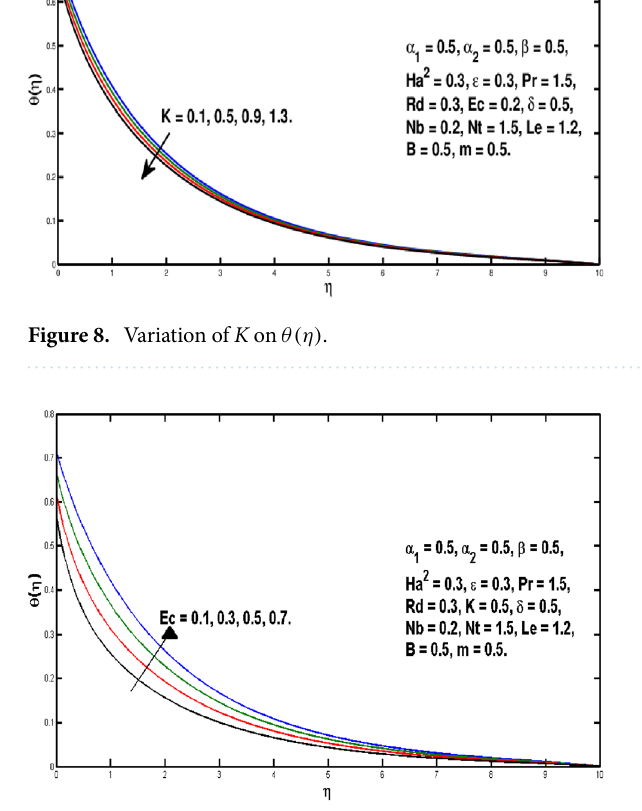
Figure 9. Variation of Ec on θ(η) .